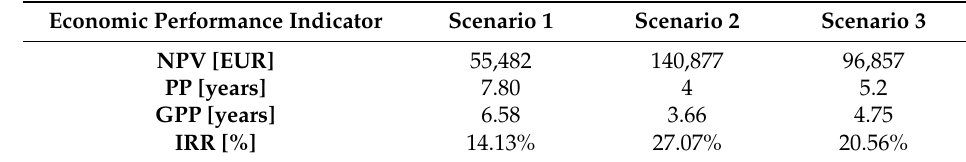
Table 3. Performance indicators values.